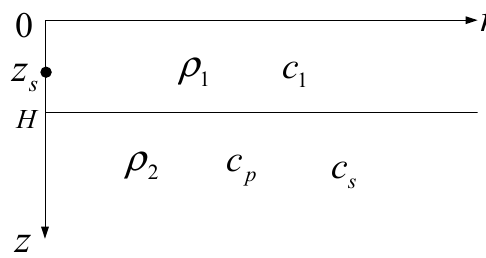
Figure 1. The Pekeris waveguide with elastic bottom.